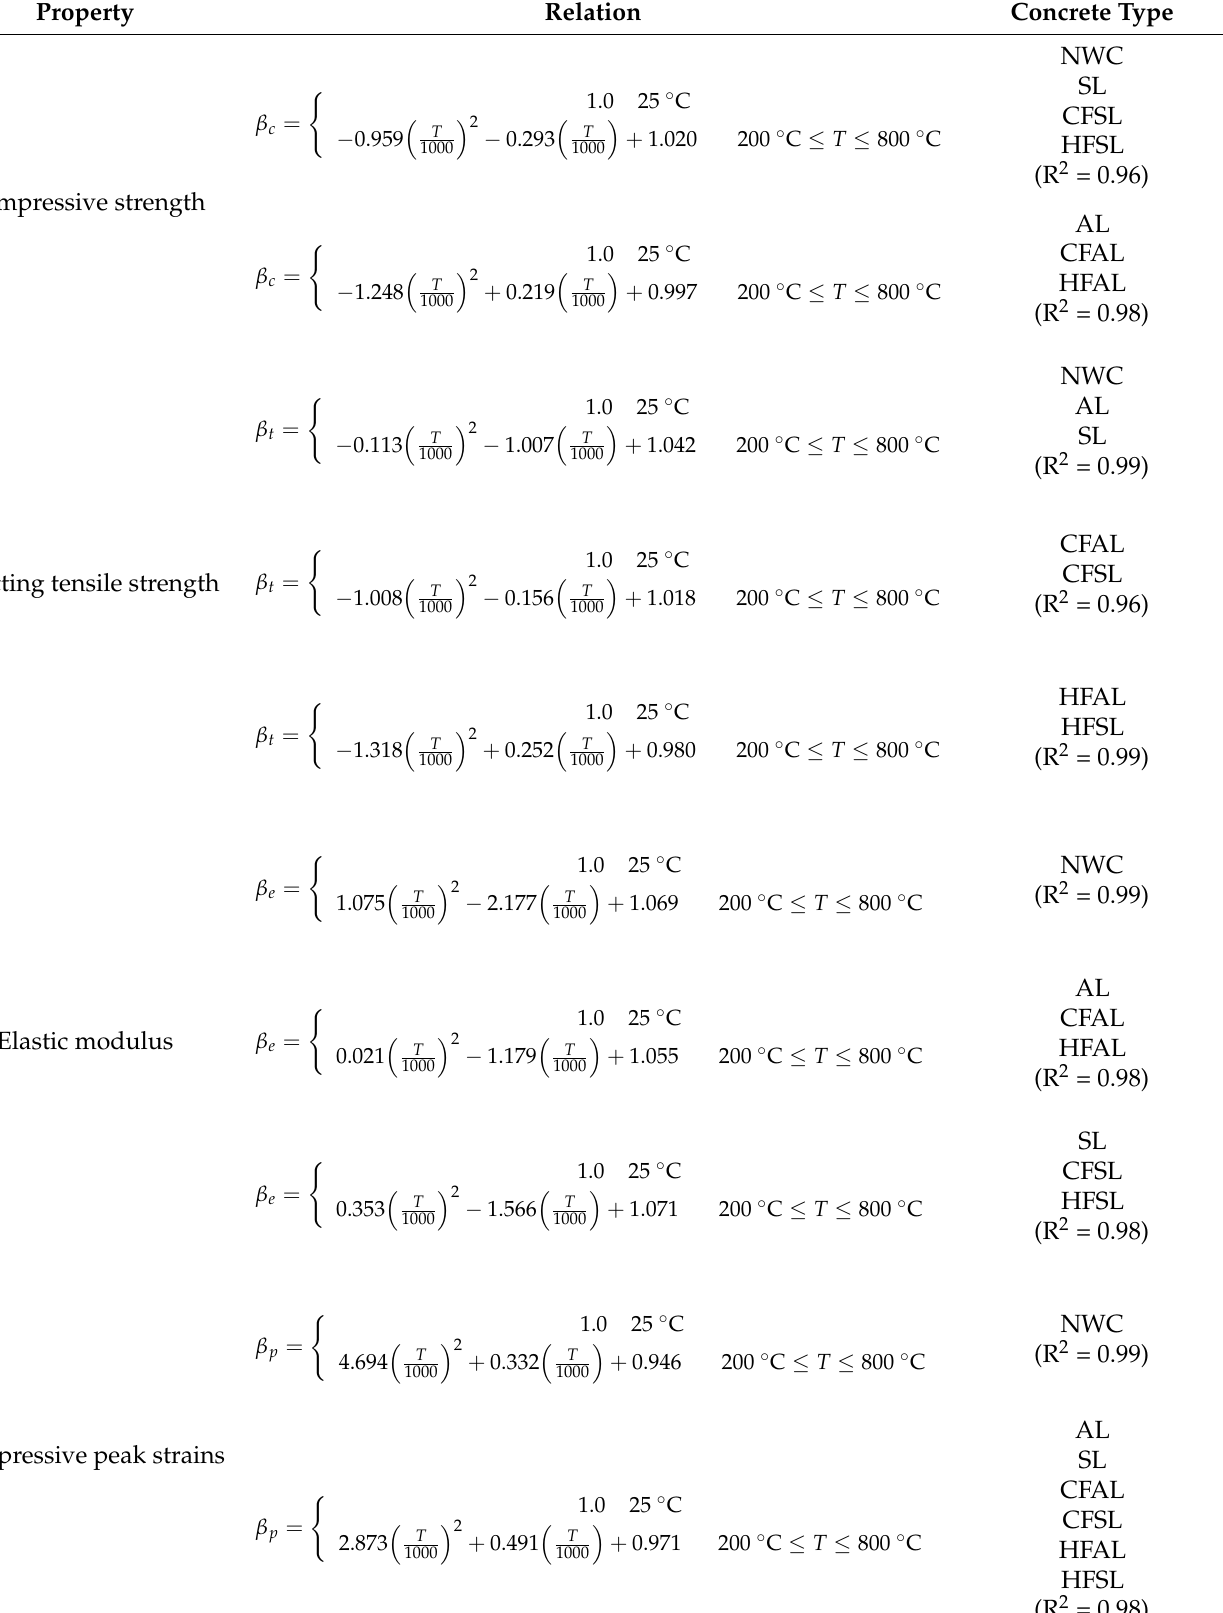
Table 6. High-temperature property relationships of different